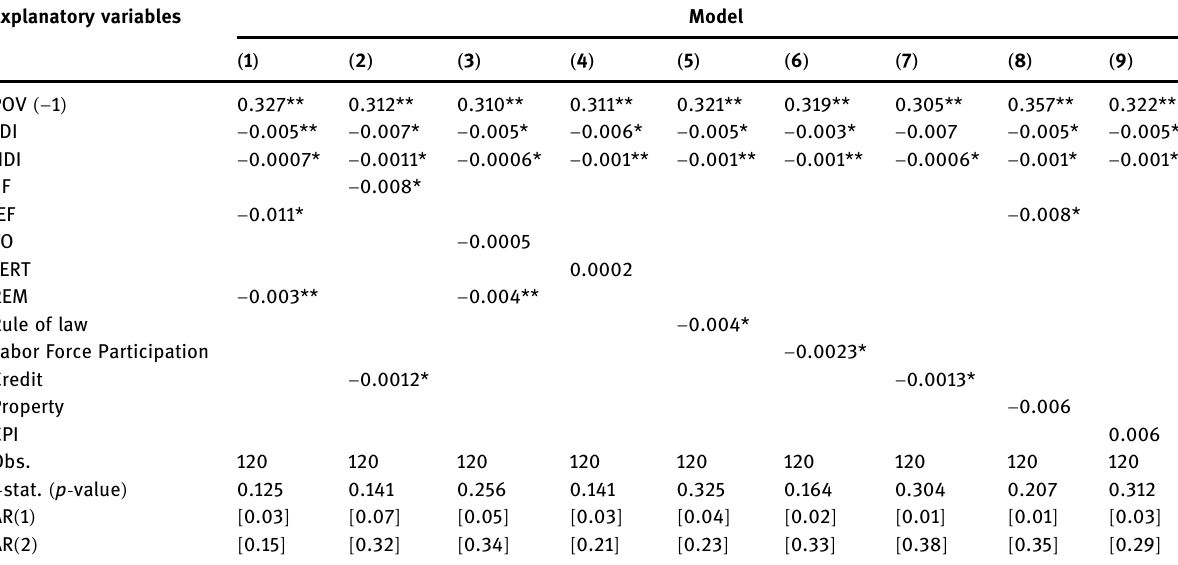
Table 5: GMM estimation results, where the dependent variable is poverty gap Explanatory variables